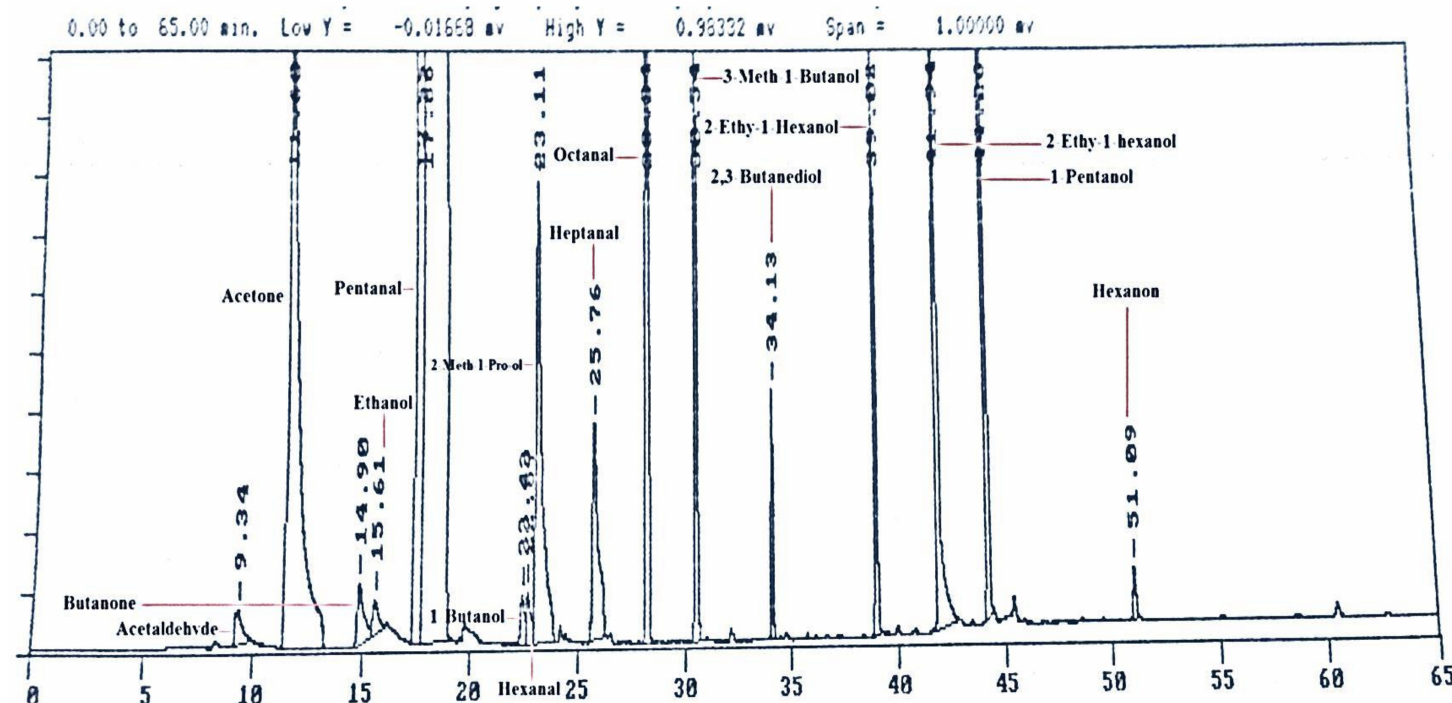
Figure 1. Standards volatile compounds run on gas chromatography coupled with flame ionization detector